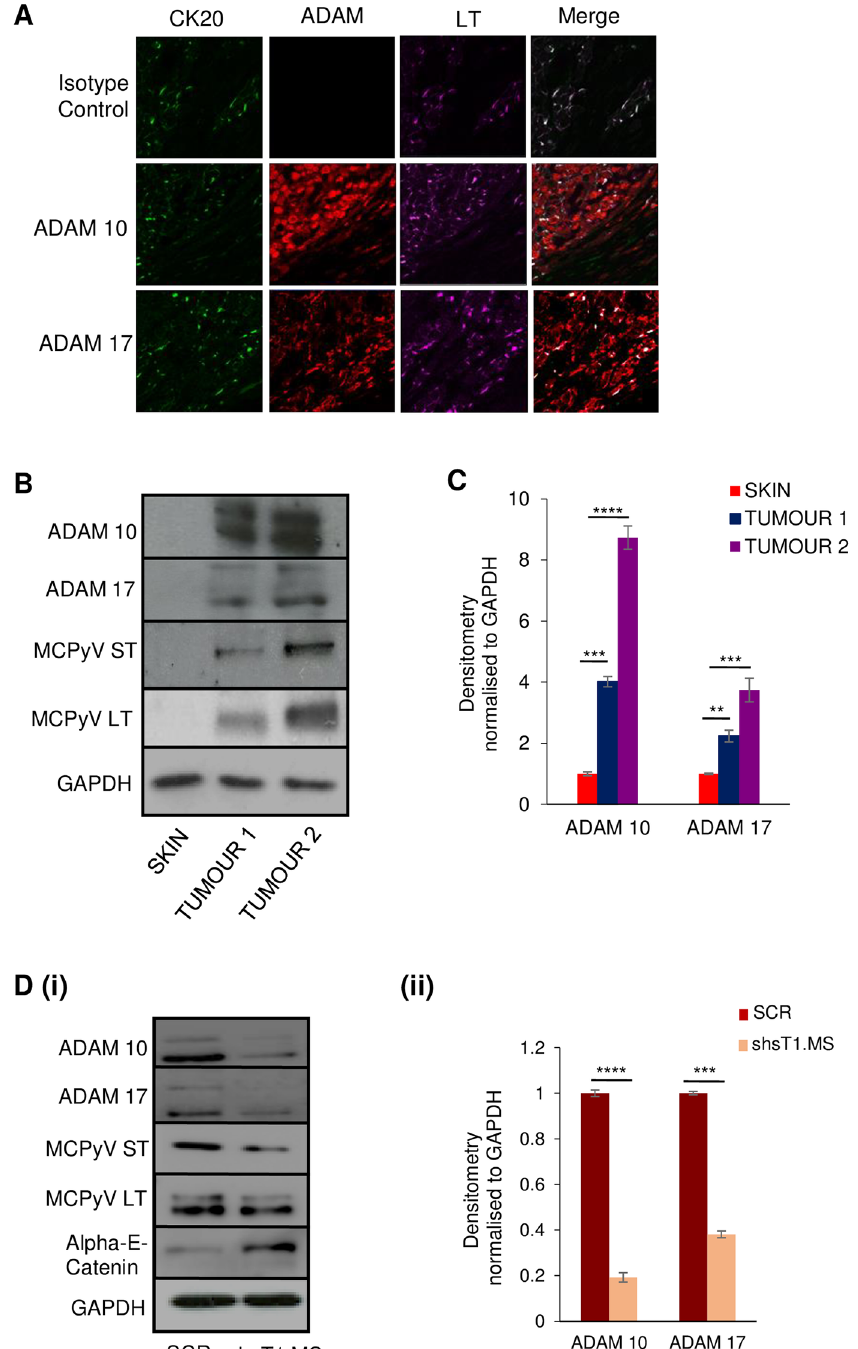
Fig 3. ADAM 10 and 17 levels are dysregulated in MCC tumour samples. (A) FFPE sections of primary MCC tumours were stained with CK20, MCPyV LT and ADAM 10- or ADAM 17-specific antibodies or an isotype negative control. Sections were then incubated with Alexa Fluor labelled secondary antibodies and analysed using a Zeiss LSM880 confocal laser scanning microscope. (B) Immunoblot analysis was performed on the cellular lysates of two independent MCC tumour samples and a negative control non-tumour cadaveric skin sample using ADAM 10- or ADAM 17-specific antibodies. GAPDH was used as a measure of equal loading, the 2T2 hybridoma was used to confirm MCPyV ST expression and the CM2B4 antibody used to confirm MCPyV tLT expression. (C) Densitometry quantification of immunoblots was carried out using the Image J software and is shown as a percentage relative to